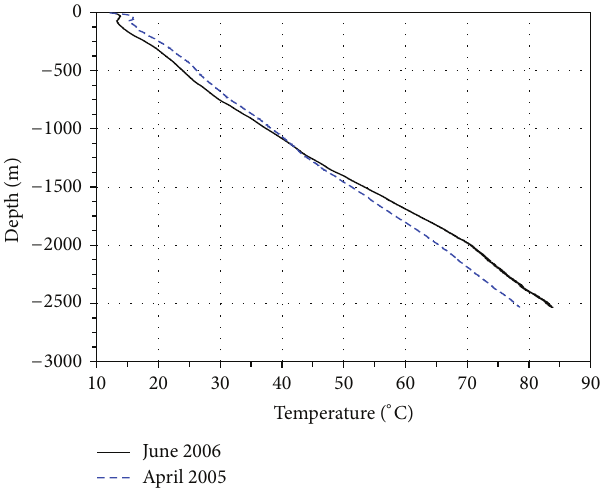
Figure 4: Temperature logs measured in the RWTH-1 borehole at different